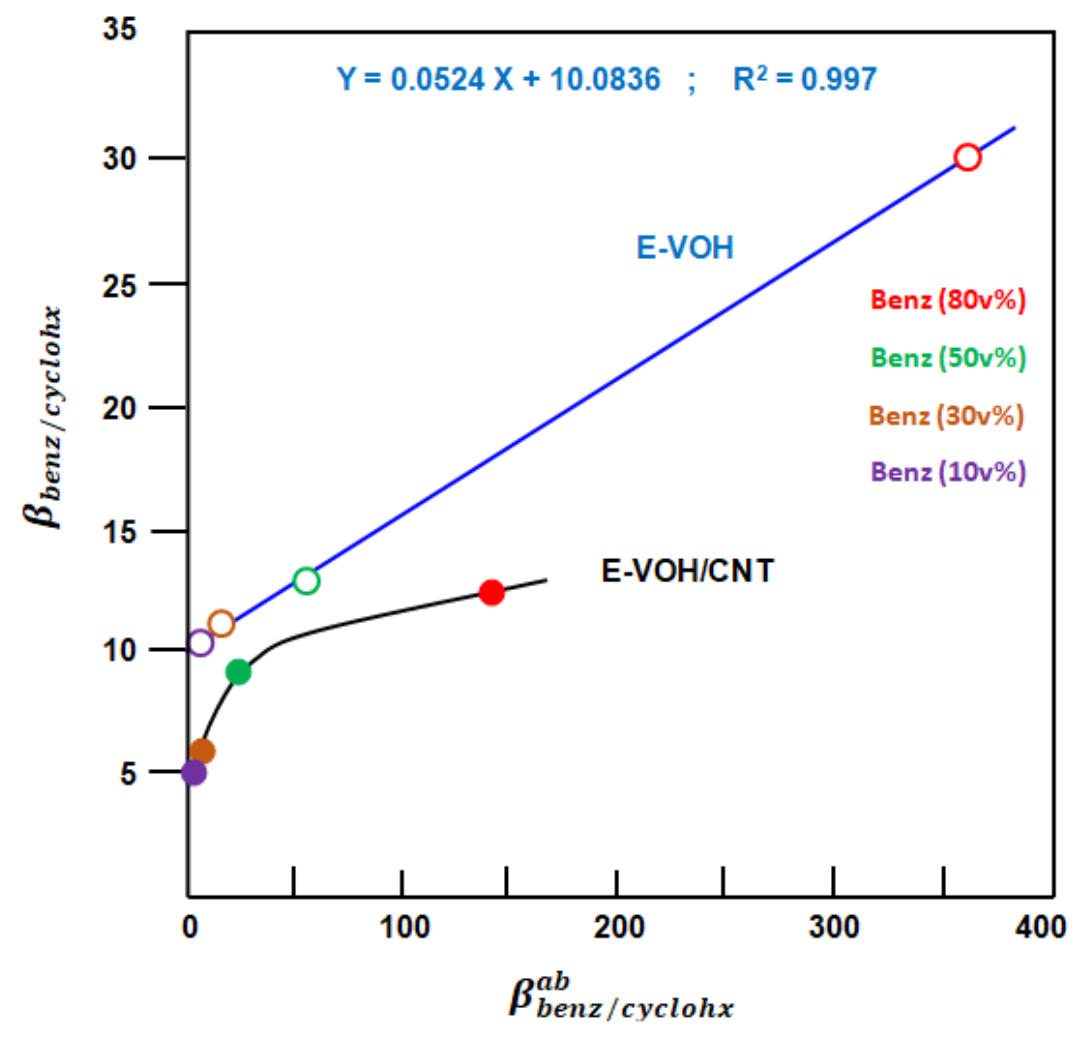
Figure 15. Variation of the separation factor versus the selective absorption factor of E-VOH and E-VOH / CNT membranes with regard to benzene in the benzene / cyclohexane mixtures. In order to examine the performance of the CNT-containing membrane over time in terms of flux and selectivity compared to that of the virgin membrane, the variation of J E − VOH / CNT / J E − VOH ratio and β E − VOH / CNT / β E − VOH ratio was plotted as a function of time, and the curves obtained for all composition mixtures are gathered in Figures 16 and 17, respectively. As can be seen from the curve profiles of Figure 15, the cumulative total flux performance of the CNT-containing membrane, with regard to that of the unloaded, changes linearly with time for virtually all of the compositions. All values of the J E − VOH / CNT / J E − VOH ratio are well above the unit, revealing that the incorporation of CNTs into the E-VOH matrix increased the performance of the cumulative total flux for all feed compositions. The slight increase of the J E − VOH / CNT / J E − VOH ratio observed for the feed containing 80% by volume of benzene is probably due to the slower depletion of the large quantity of benzene in the feed during the separation process. For the azeotropic mixture, the performance increased faster and stabilized during the two last hours at 4.12. However, for the two feeds containing less benzene, the cumulative total fluxes ratios significantly decreased following practically the same trend and converge with that of 80 v% of the aromatic component towards the same value (2.40 ± 0.15) reached at the end of the separation process. The decrease in the flux performance for the feed containing 10 and 30 v% benzene seems to be mainly due to its rapid exhaustion over time until the two compositions are equal, which reflects the convergence of the two corresponding curves at the end of the